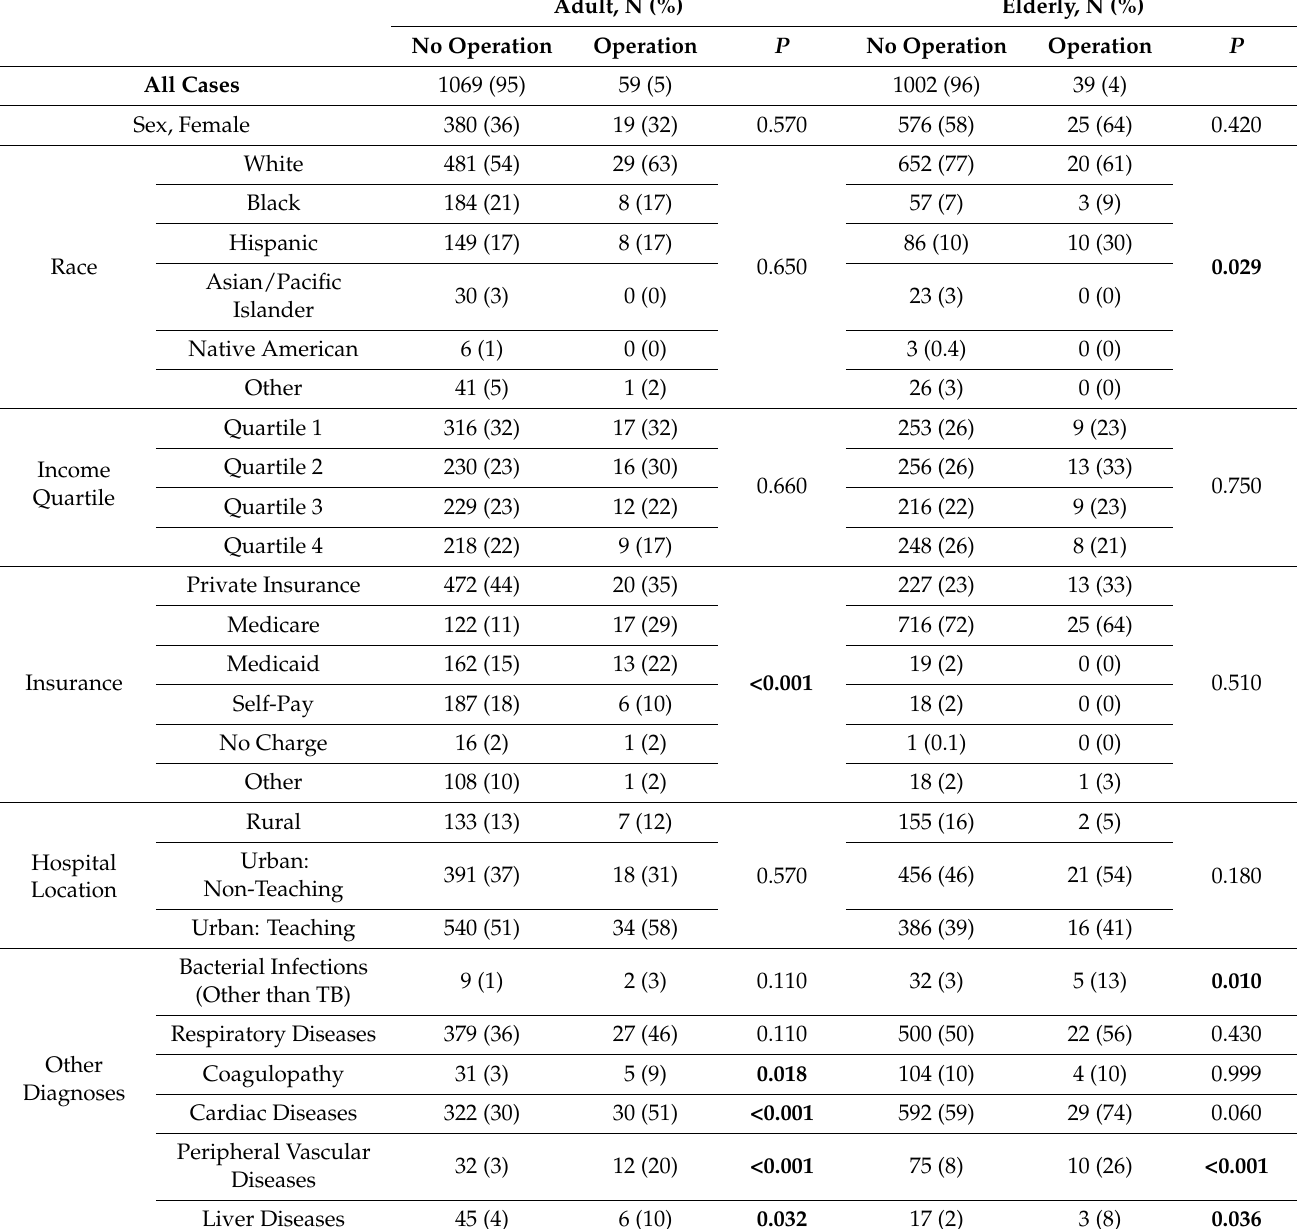
Table 3. Characteristics of emergently admitted patients with a primary diagnosis of blunt chest wall injury. Data are stratified according to operation status, NIS 2004–2014. Adult, N (%) Elderly, N (%) No Operation Operation P No Operation Operation